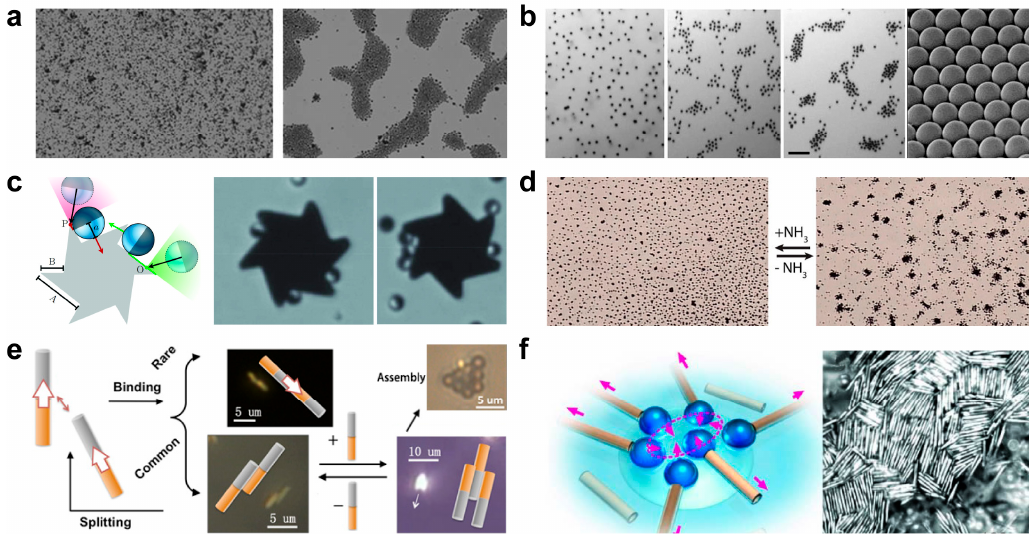
Figure 2. Chemical induced swarming and assembly of micro/nanoparticles. ( a ) Reversible swarm formation of unmodified Au microparticles induced by repetitive hydrazine additions (reproduced from [41]). ( b ) The swarming behavior of the Ir-based micromotors (reproduced from [42]). ( c ) Self-Assembly of micromachining systems powered by Janus micromotors (reproduced from [43]). ( d ) Transition between exclusion and schooling behaviors based on self-diffusiophoresis (reproduced from [44]). ( e ) Catalytically powered dynamic assembly of rod-shaped nanomotors and passive tracer particles (reproduced from [47]). ( f ) Self-assembled tubular microengines (reproduced from [48]).